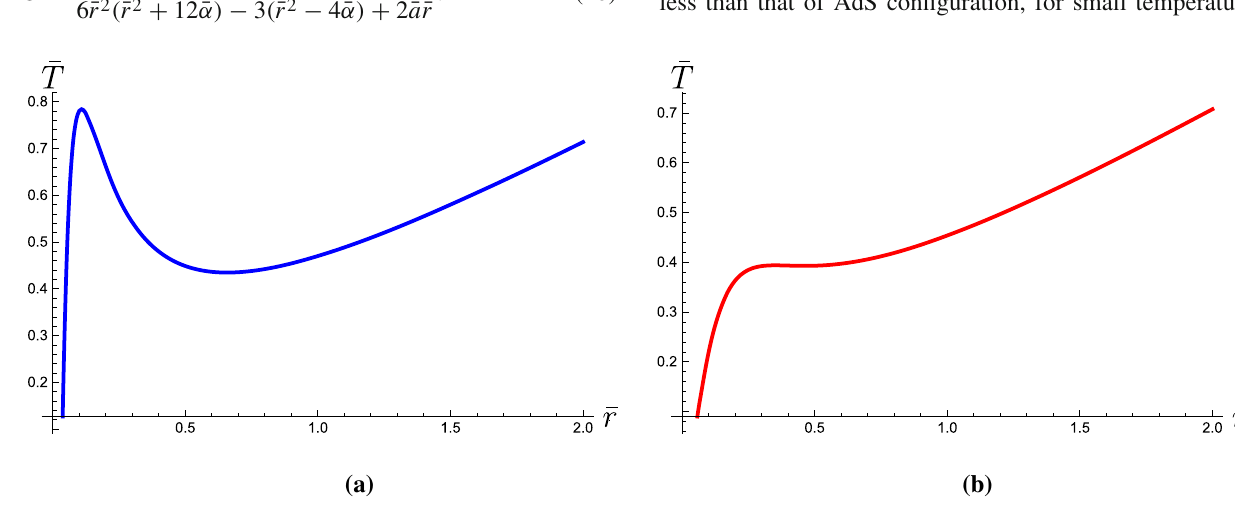
Fig. 3 ¯ T vs. ¯ r plots. a ¯ a = 0 . 1 , ¯ α = 0 . 001 and b ¯ a = 0 . 1 , ¯ α = 0 .